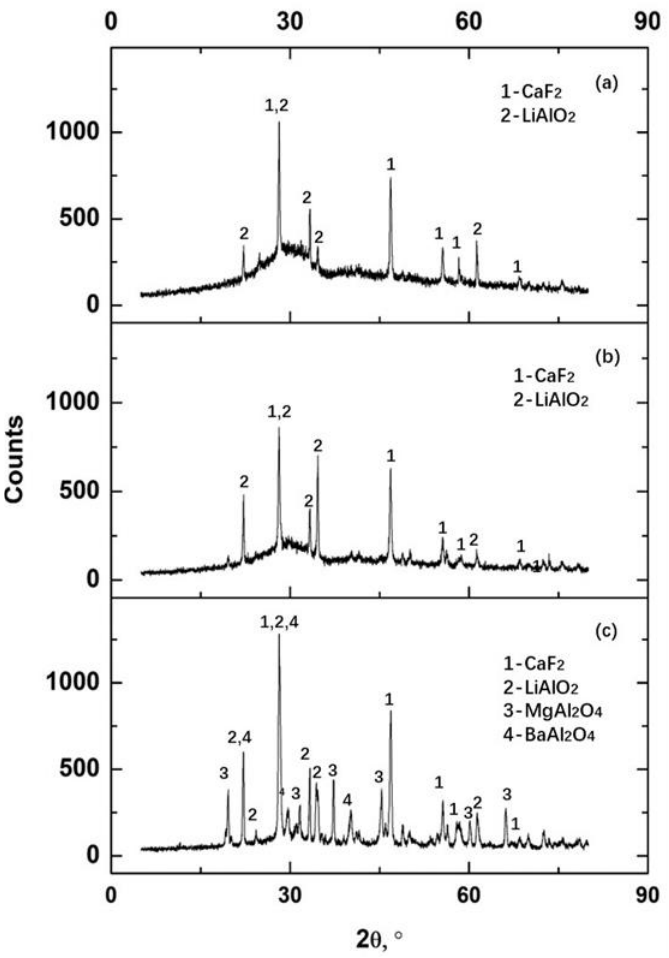
Figure 4. Typical XRD patterns of slag film powders: ( a ) No. 1 slag; ( b ) No. 2 slag; ( c ) No. 3 slag. Bulk slag temperature for film solidification: 1350, and solidification time: 30 s. Table 3. Major crystal phases in films with different solidification times and slag bulk temperatures.